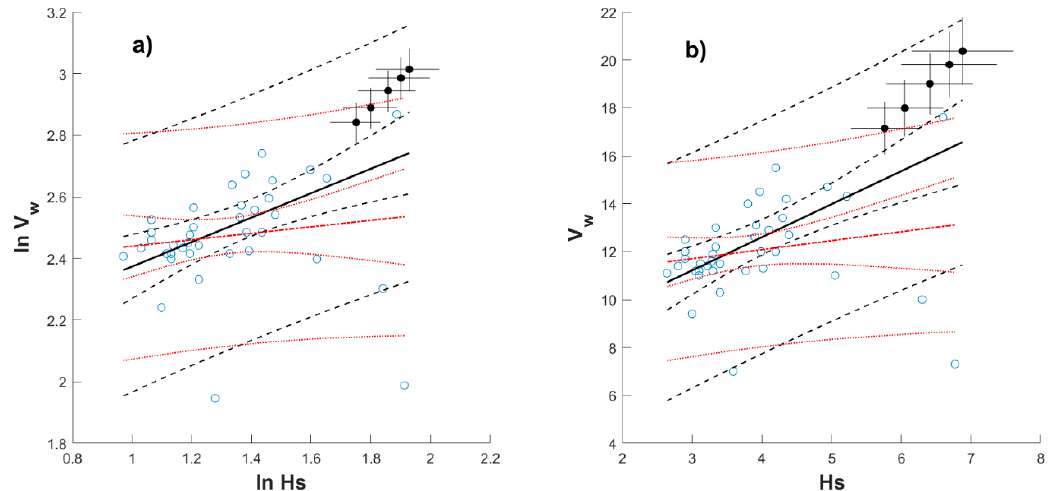
Figure A7. Regression lines and confidence intervals including (solid and dashed lines, respectively) and excluding (dashed–dotted and dotted lines, respectively) T -yr values for September; ( a ) and ( b ) for logarithmic space and linear space, respectively. Filled circles represent T -yr values with embedded perpendicular lines indicating confidence intervals from GEV models.